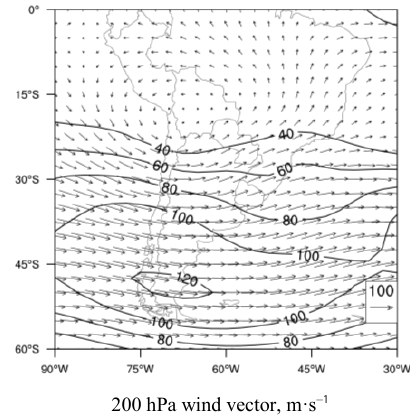
Fig. 7. Average wind speed (contour) and direction (arrows) at 200 hPa for three-day heat waves during the summer period of the years 1977 − 2018 in the Province of Mendoza. Figure built from images provided by the Earth System Research Laboratory of the National Oceanic and Atmospheric Administration, Boulder, Colorado, on its website